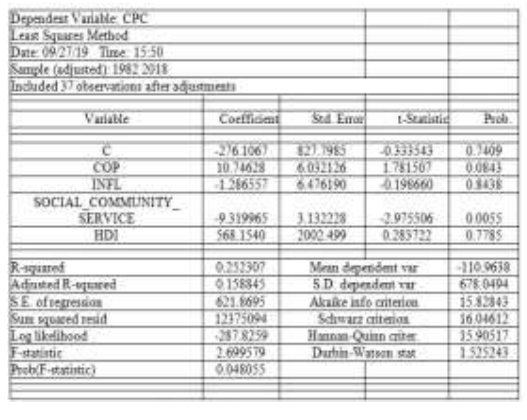
Table 5: Model 2 (Least Square Method of Analysis) (2)